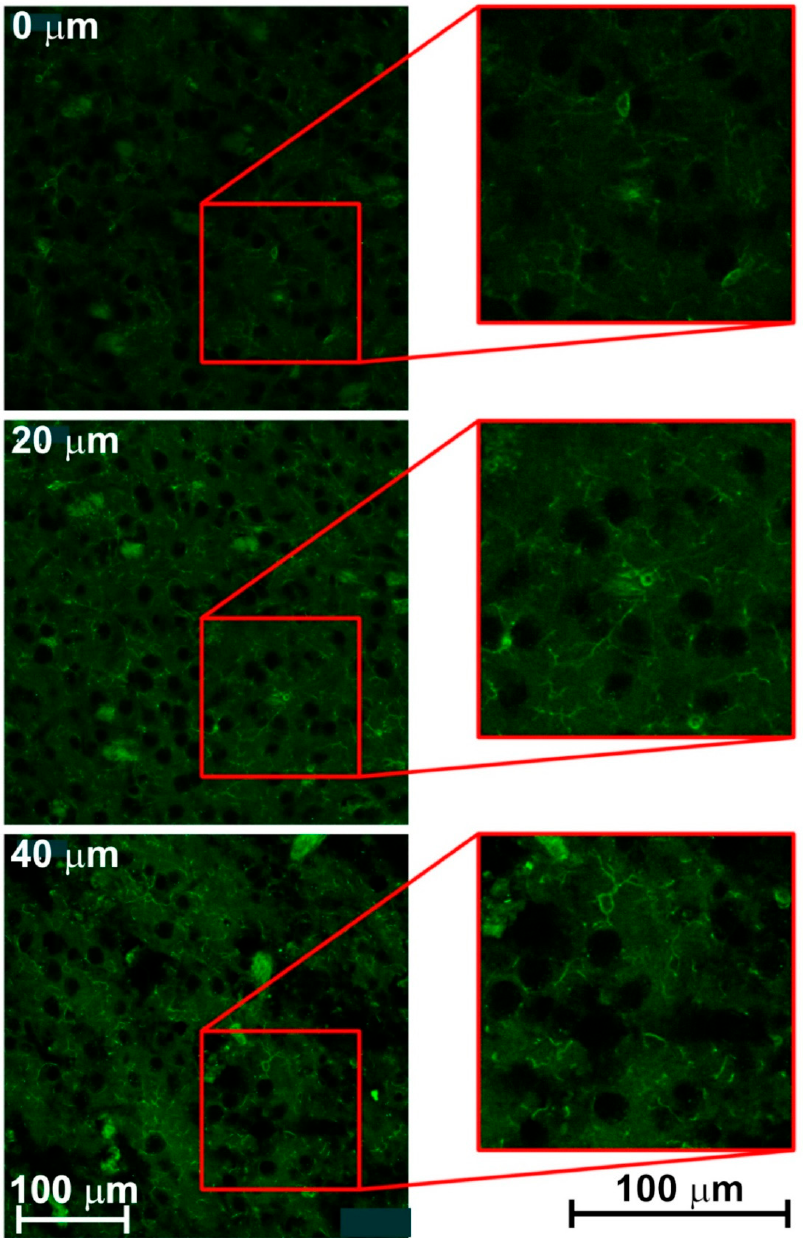
Figure 5. Images of the rat brain parietal cortex created by one-photon confocal laser scanning microscope Leica TCS SP8 X after hydrogel-forming and staining; experimental conditions in 2.5 Brain tissue staining and confocal microscopy. Three different samples at depths 0, 20, and 40 μ m of histological sections of the parietal cortex of rat brain employing Iba-1 staining. Positive microglial cells appear green.